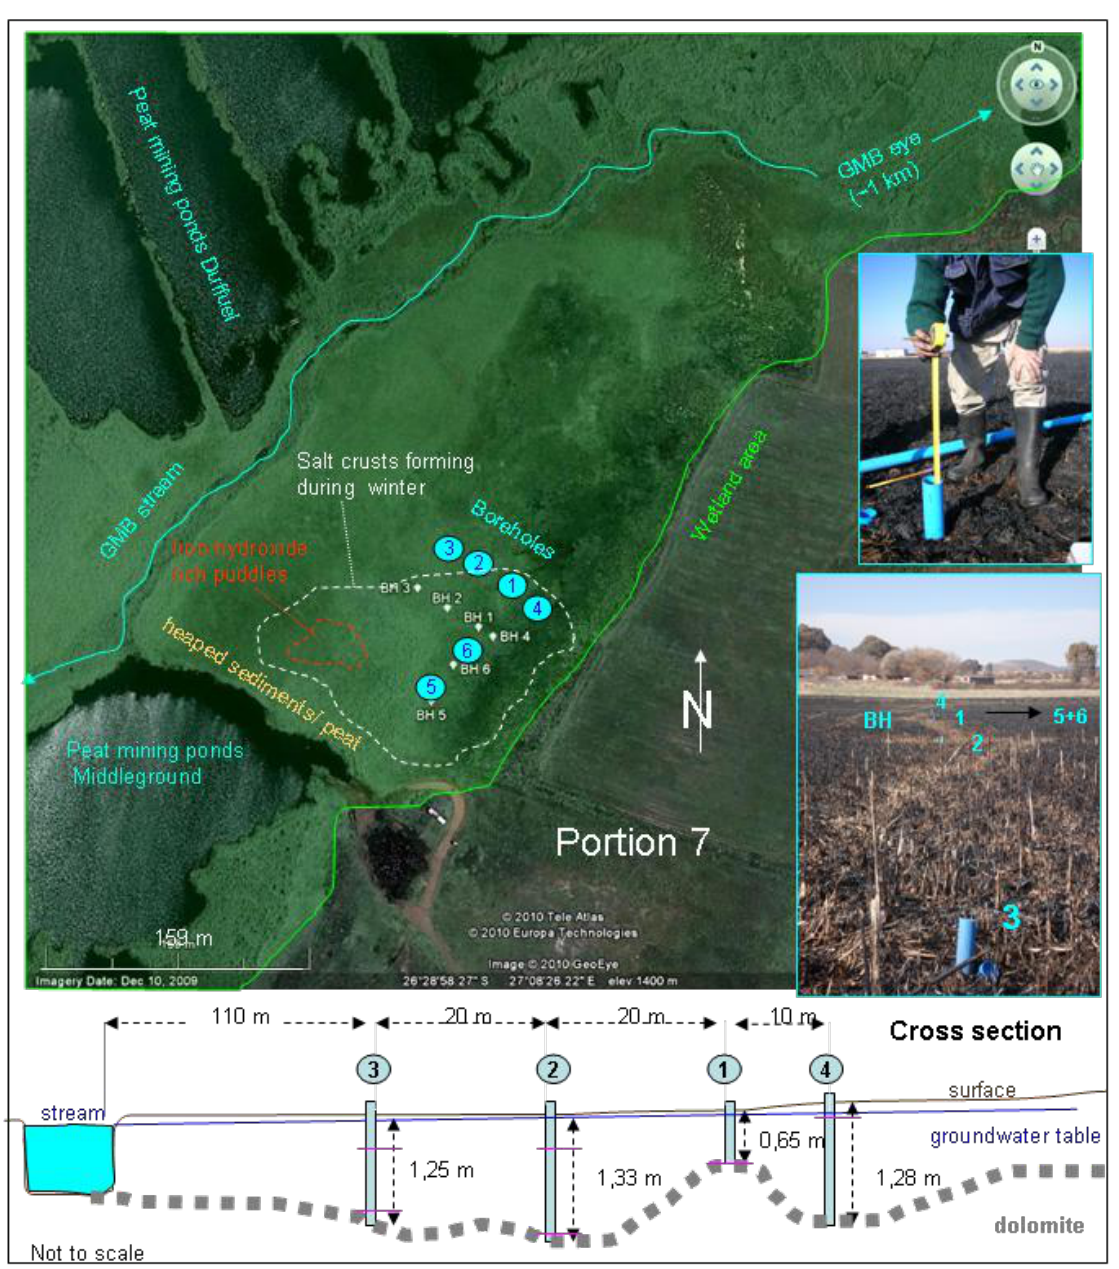
Figure 14. The location and horizontal and vertical structure of the borehole transect at portion